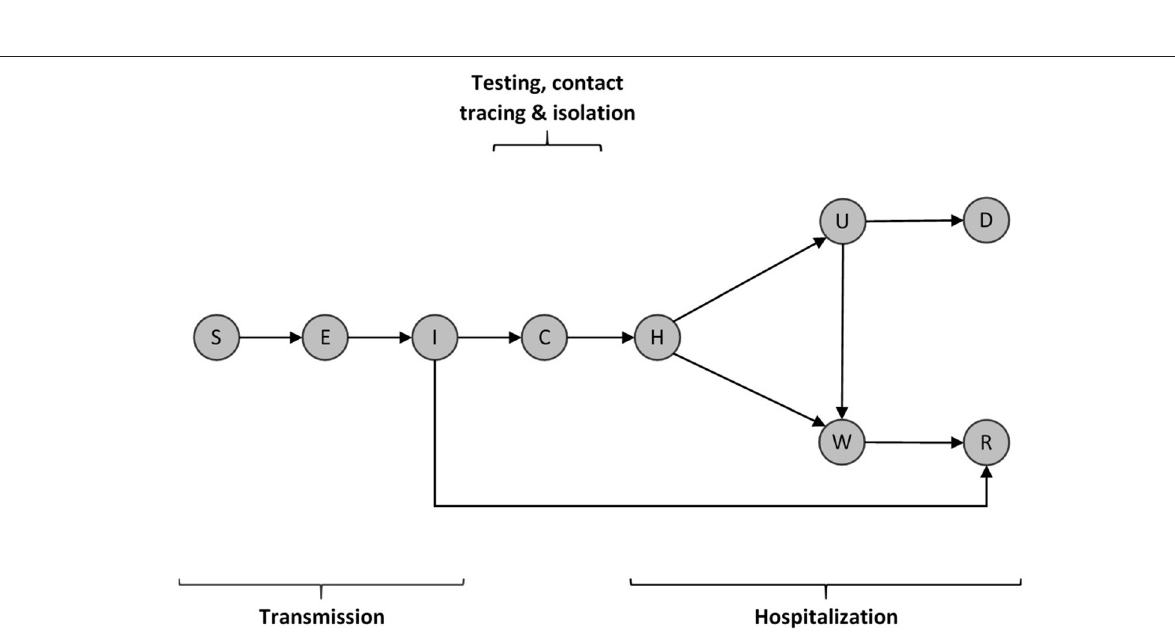
FIGURE 1 | Cumulative number of reported COVID-19 cases in Kuwait along with a timeline of events.